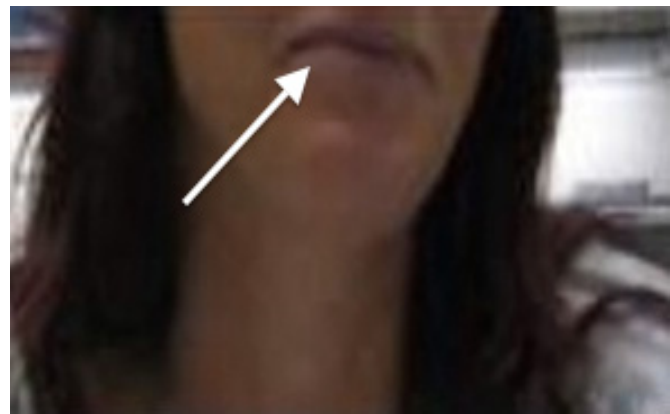
Figure 2. White arrow indicates blue/grey discoloration of lips .